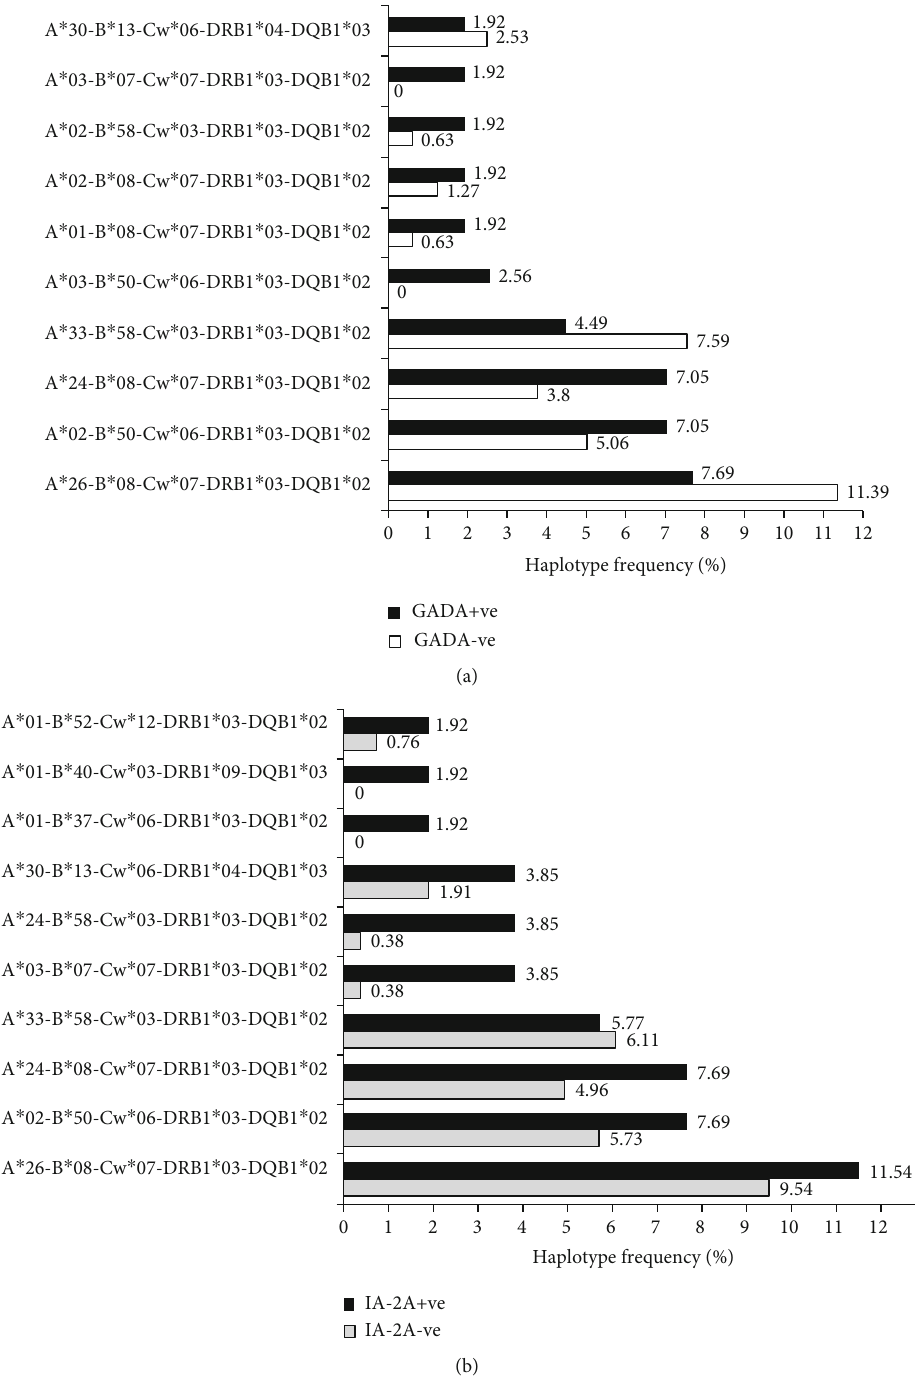
Figure 1: Comparative distribution of 10 most common HLA-A-B-Cw-DRB1-DQB1 haplotypes between (a) GADA+ ( N = 78 ) and GADA – ( N = 79 ) and (b) IA2A+ ( N = 26 ) and IA2A – ( N = 131 ) T1D patients from North